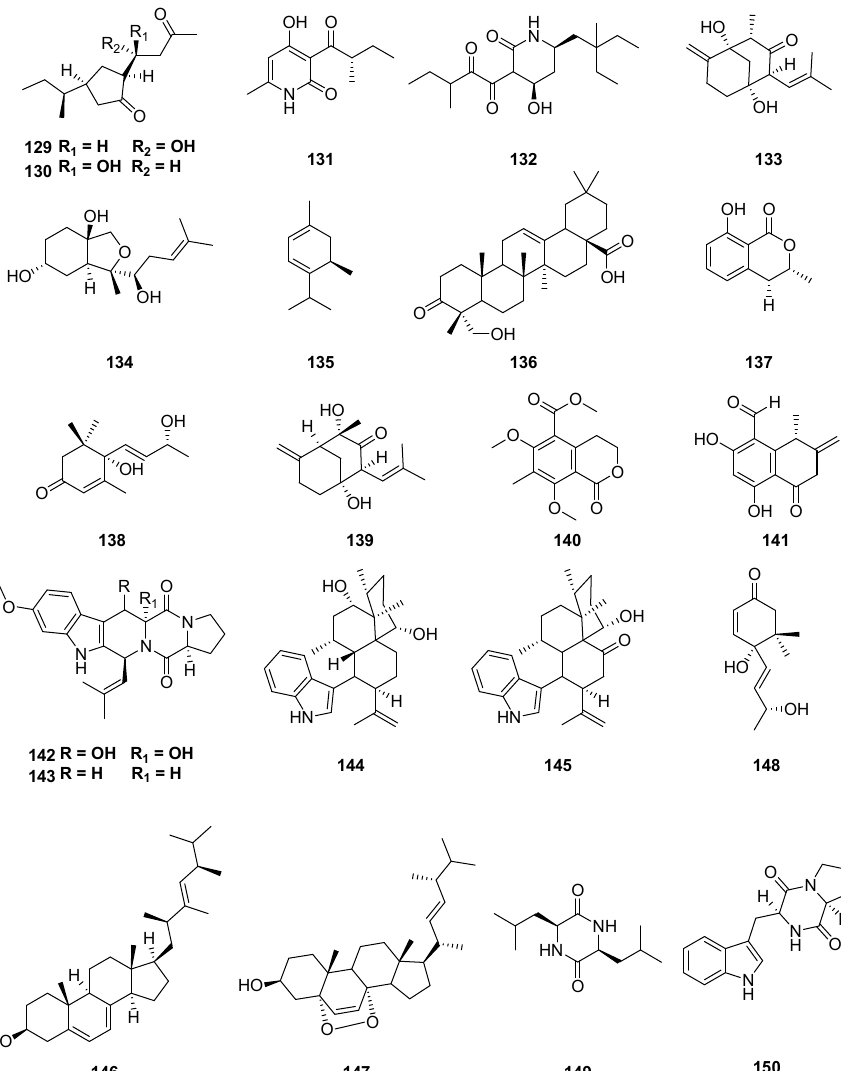
Figure 11. Compounds extracted from endophytic fungi, C. gloeosporioides obtained from Uncaria